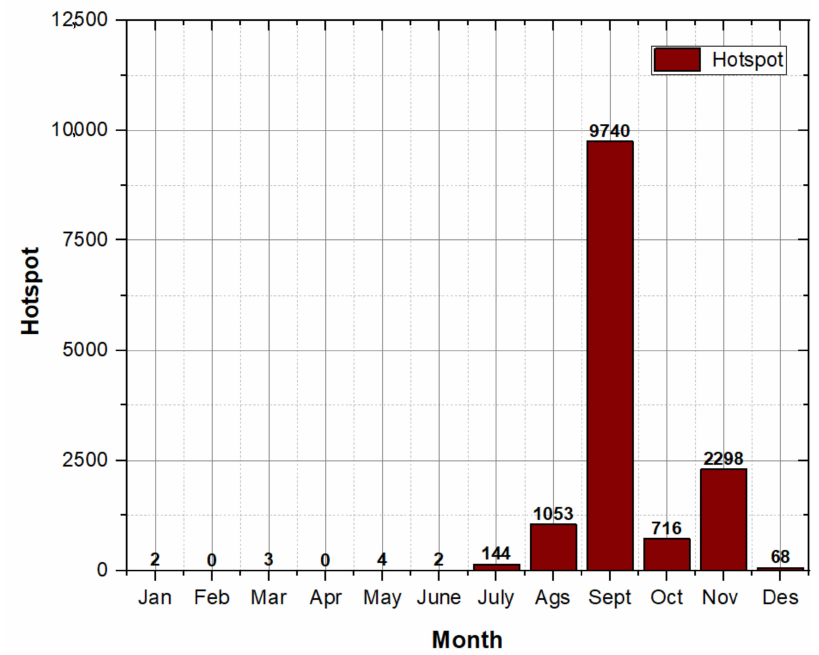
Figure 9. Hotspot intensity per month at the research site throughout